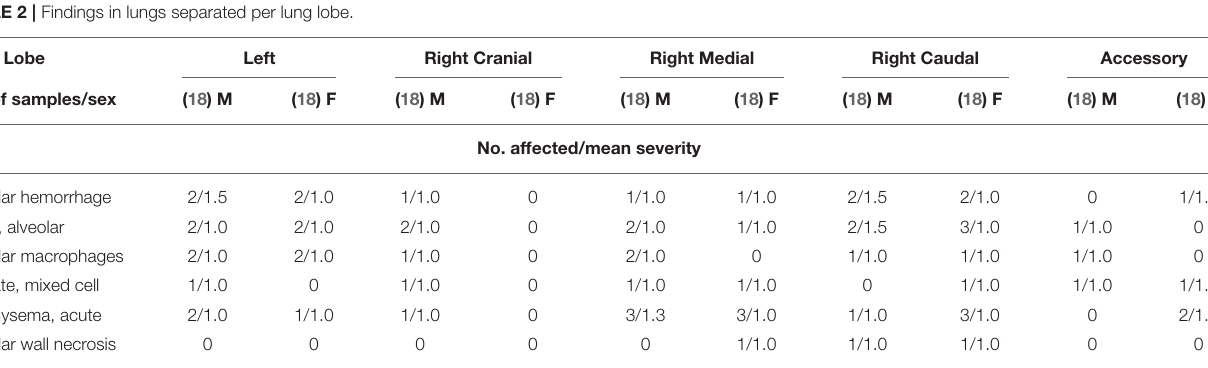
TABLE 2 | Findings in lungs separated per lung